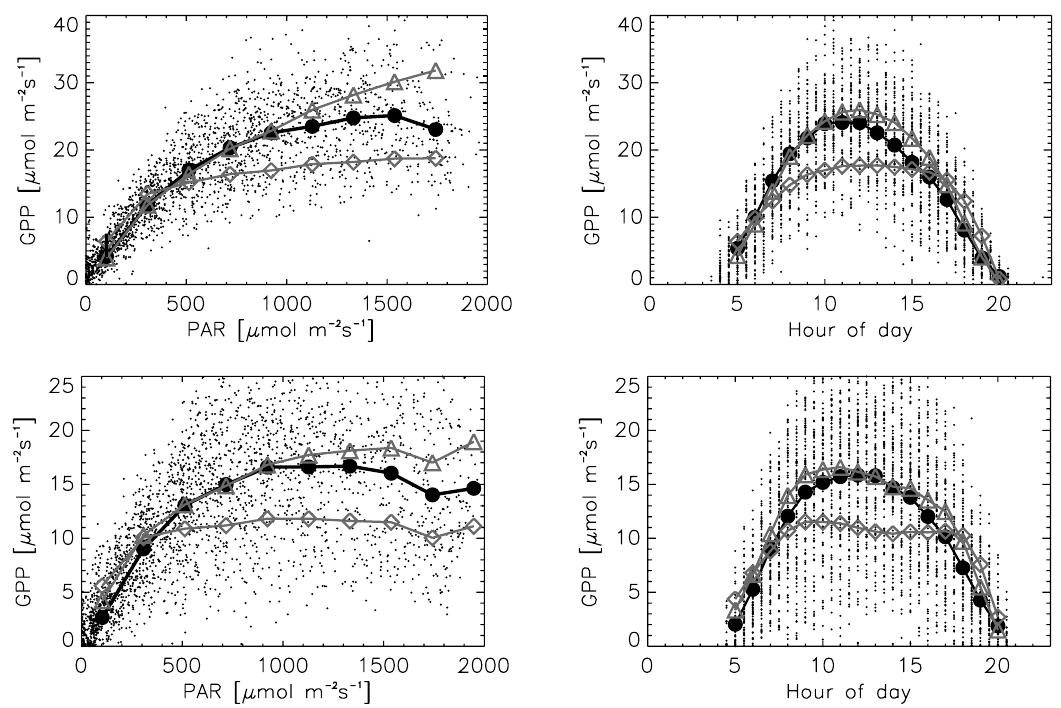
Fig. 1. Evaluation of modelled carbon uptake at a temperate broadleaf (top panel; Knohl et al., 2003) and a needleleaf site (bottom panel; Rebmann et al., 2010). Plots on the left represent the light response of Gross Primary Productivity (GPP) and on the right represent the diurnal cycle of GPP. Lines represent data (closed circles) and model simulations using the big leaf (open diamonds) and multi-layer approaches (open triangles). On the left, both data and simulations are averaged over 200 micromol quanta m − 2 s − 1 intervals, and on the right data and simulations are averaged over half hour time periods. In all cases dots represent half-hourly estimated GPP from eddy